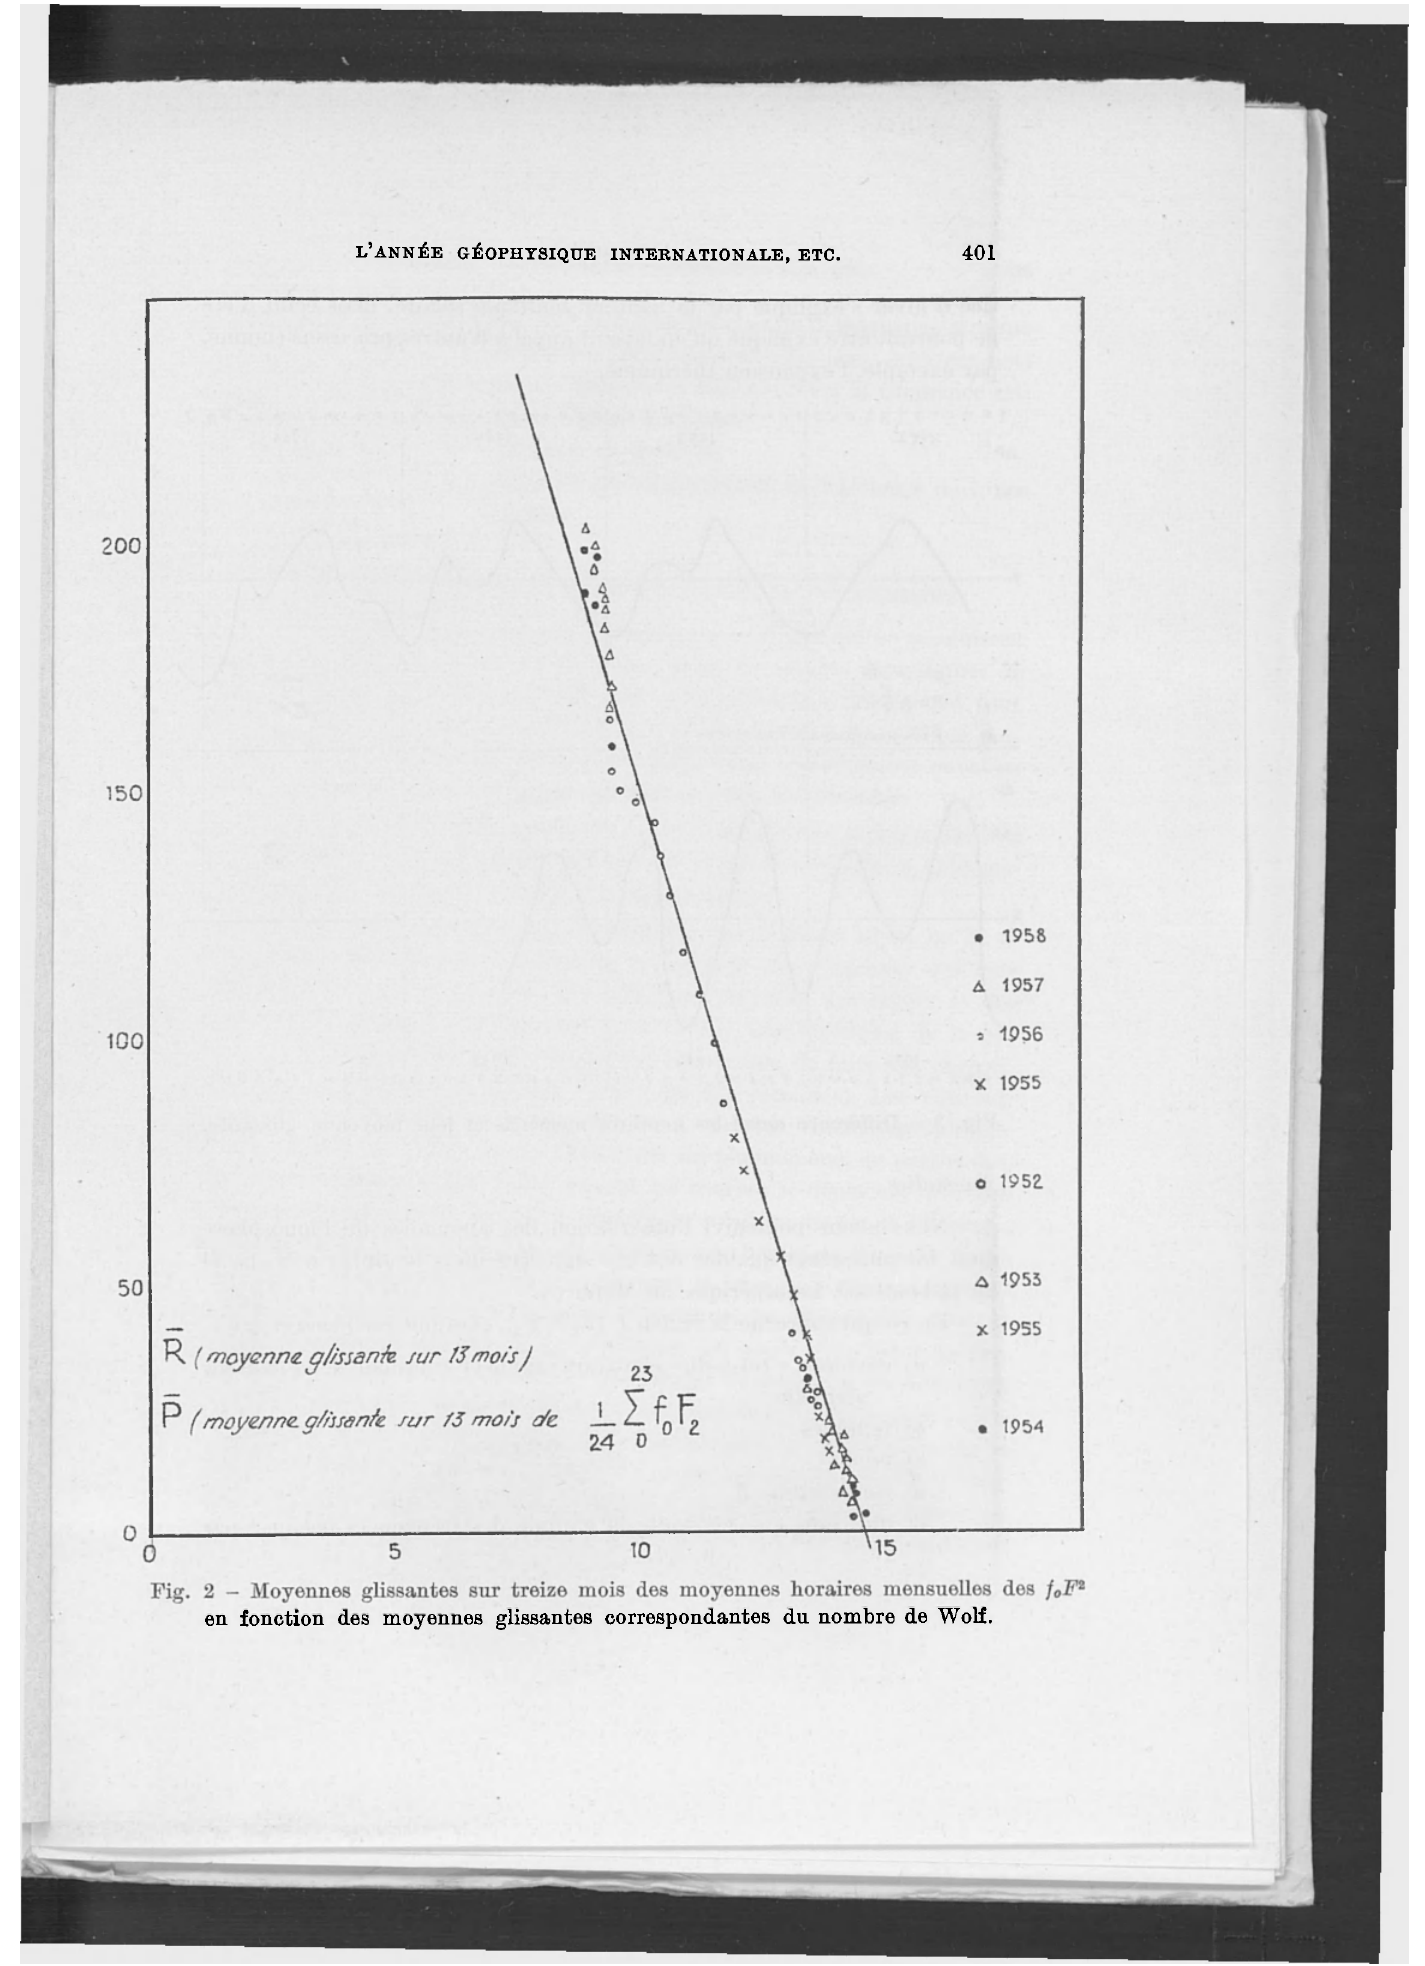
en fonction des moyennes glissantes correspondantes du nombre de